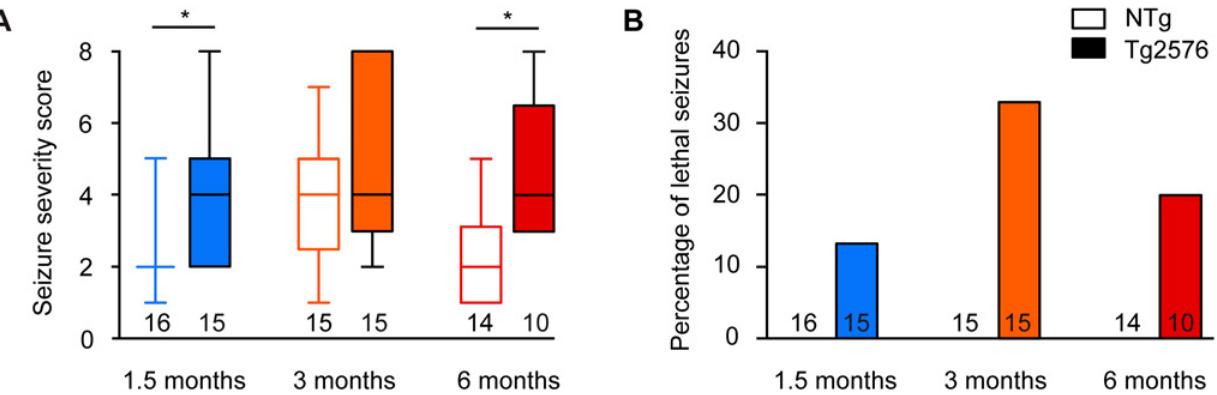
Fig 1. Tg2576 mice show high susceptibility to pharmacologically-induced seizures from early age on. (A) Seizure severity score of 1.5, 3 and 6 month-old Tg2576 male mice and non-transgenic (NTg) age-matched littermates. Whiskers boxes represent the interquartile distribution. Number of mice in each group is indicated below the boxes. Tg2576 mice exhibit more severe seizures than NTg at 1.5 and 6 months of age (Dunn ’ s tests: p < 0.05 for Tg2576 vs NTg at 1.5 and 6 month-old). (B) Proportion of animals that died during PTZ-induced seizures in 1.5, 3 and 6 month-old Tg2576 and NTg mice. Note that only transgenic animals exhibit lethal seizures. Numbers over the horizontal axis indicate the number of mice used in each experimental group.